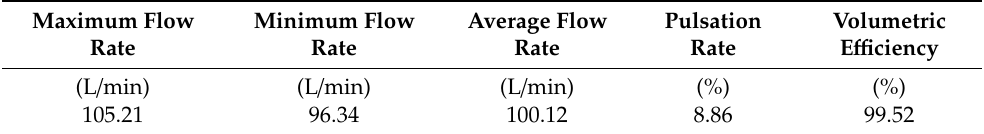
Table 5. Flow characteristic data under no-load conditions.